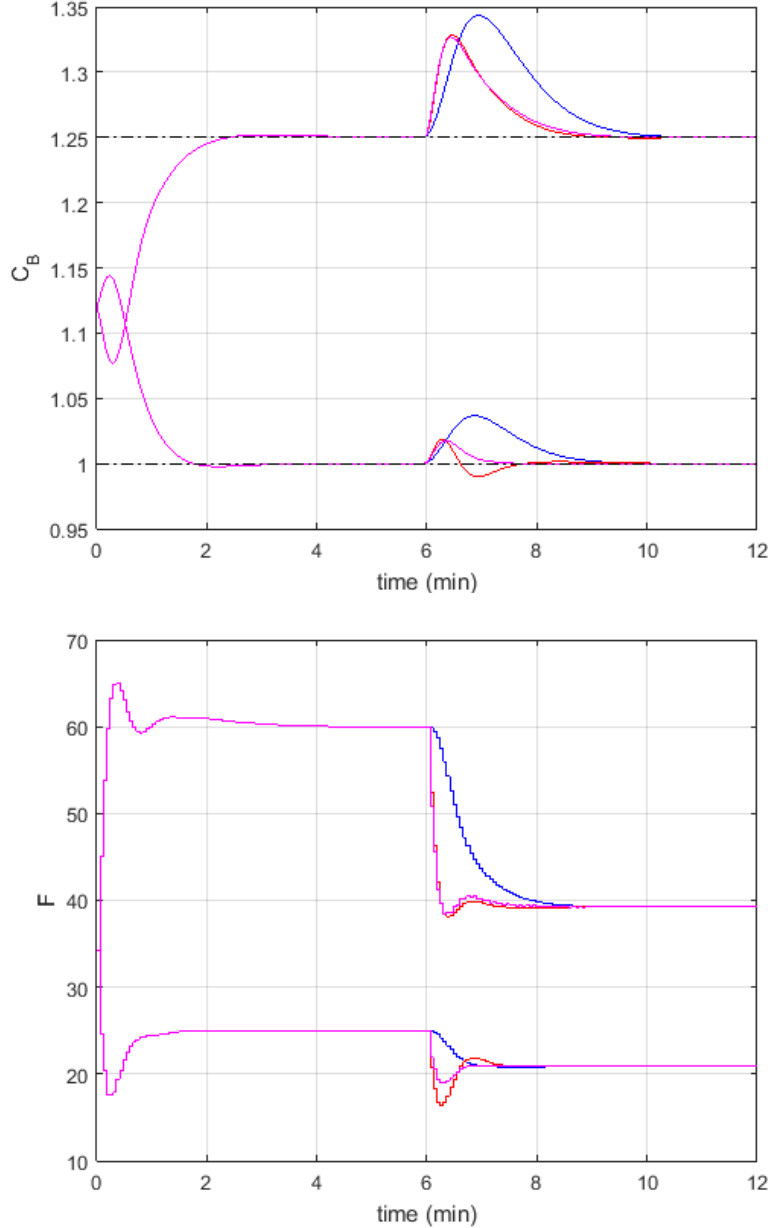
Figure 7. Responses of the control system with FMPC1 algorithm and λ = 0.0001 to changes in the setpoint to C B 1 = 1 mol/L and C B 2 = 1.25 mol/L and to the change of the disturbance by 10% in